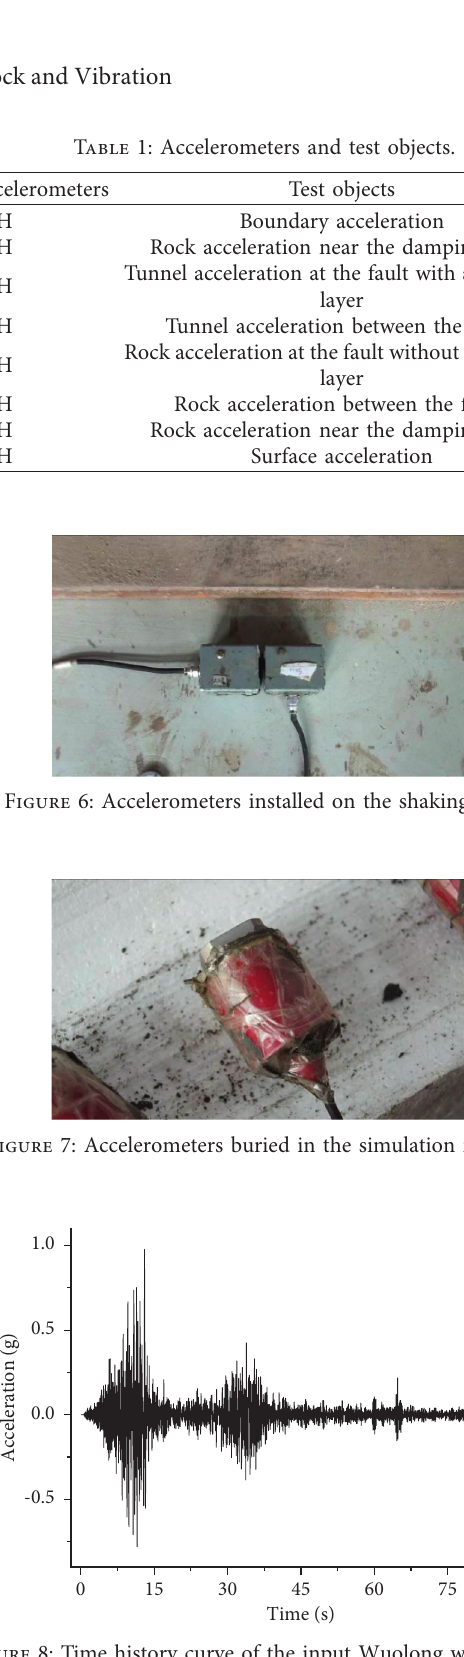
Figure 8: Time history curve of the input Wuolong wave for the shaking table test.